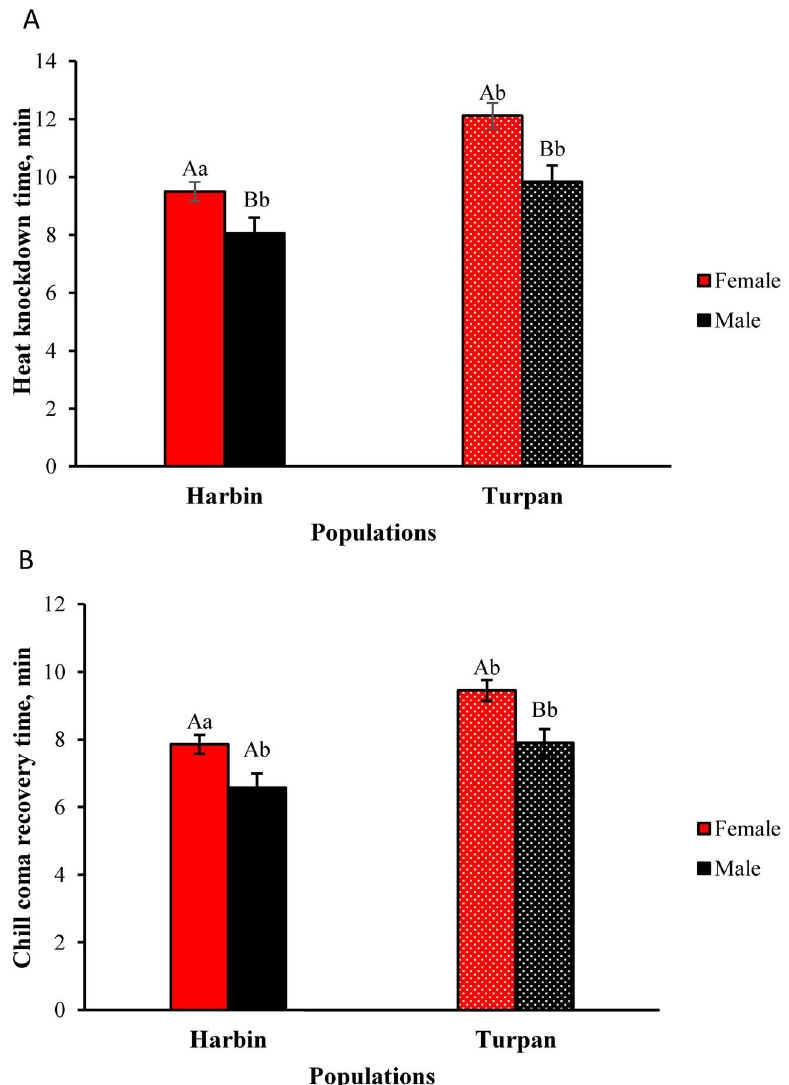
Figure 2. Heat knockdown time (A) and chill coma recovery time (B) (min) for the Harbin and Turpan populations of the Bemisia tabaci MED cryptic species. The numbers represent the means 6 1 S.E.; N=100 in all cases. Bars topped with a different capital letter indicate a significant difference between the females and males within the same population; the different lowercase letters indicate a significant difference in the same sex between the two populations of B. tabaci MED cryptic species (two-way ANOVA followed by post hoc Tukey-Kramer multiple comparison test, P , 0.05).